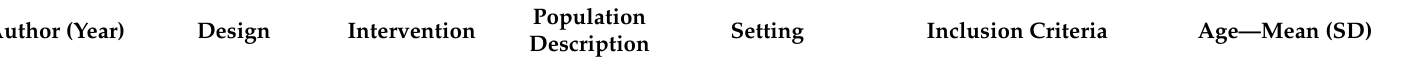
Table 1. Summary of the studies included on oral health care interventions in patients with Alzheimer’s